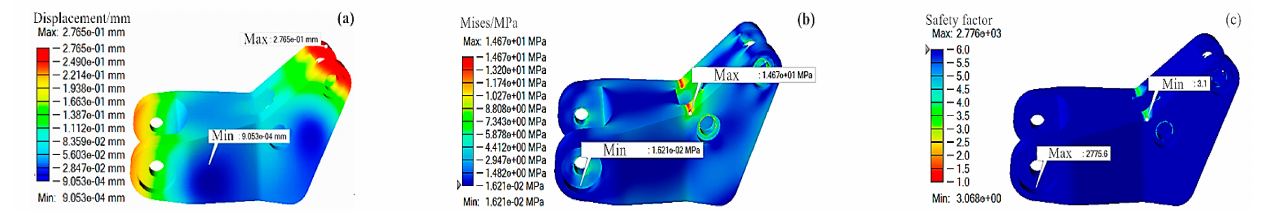
Figure 2. Strength analysis of shock-absorbing bearing parts: ( a ) Displacement nephogram; ( b ) Stress nephogram; and ( c ) Safety factor.